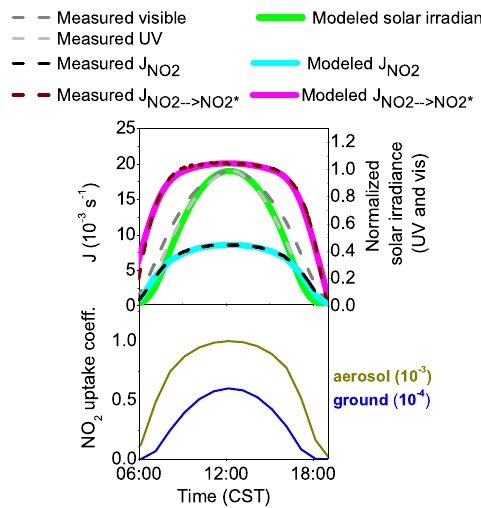
Fig. 1. Upper panel: time series of measured NO 2 photolysis frequencies J NO , photolysis frequency of NO 2 to NO ∗ 2 , J NO , normalized solar visible irradiance, and UV irradiance are shown as dashed lines (see Wong et al., 2012 for details on the observations). Modeled J NO , J NO and normalized solar irradiance are shown as thick lines. Lower panel: time series of calculated reactive NO 2 uptake coefficient on the ground and on aerosol in model runs 2 and 3.